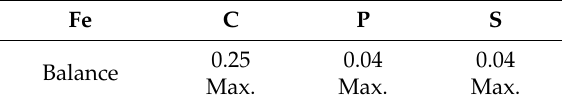
Table 2. Chemical composition of SPW400 (wt.%).